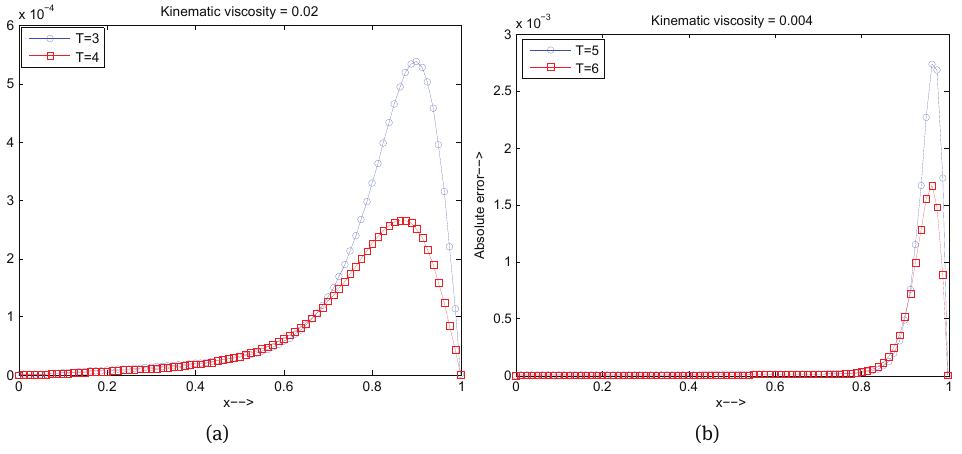
Fig. 18: Absolute error of numerical solutions for Example 2 at different times with Δx = 0.0125 and Δt = 0.001 (a) ν = 0.02 (b) ν = 0.004 .